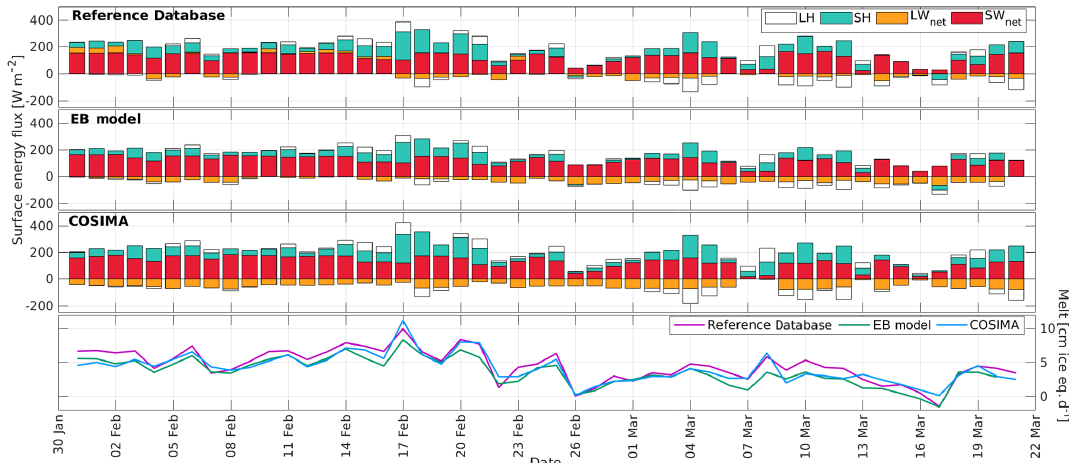
Figure 7. Daily modeled and measured energy fluxes and melt during summer 2006 for Mocho Glacier using the three methods.